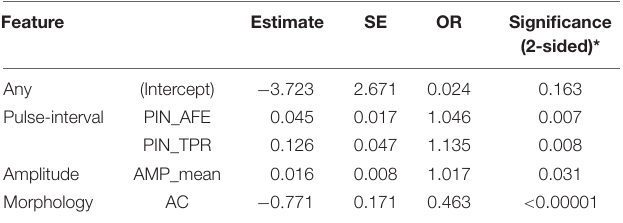
TABLE 4 | Features in the multivariate predictor model.